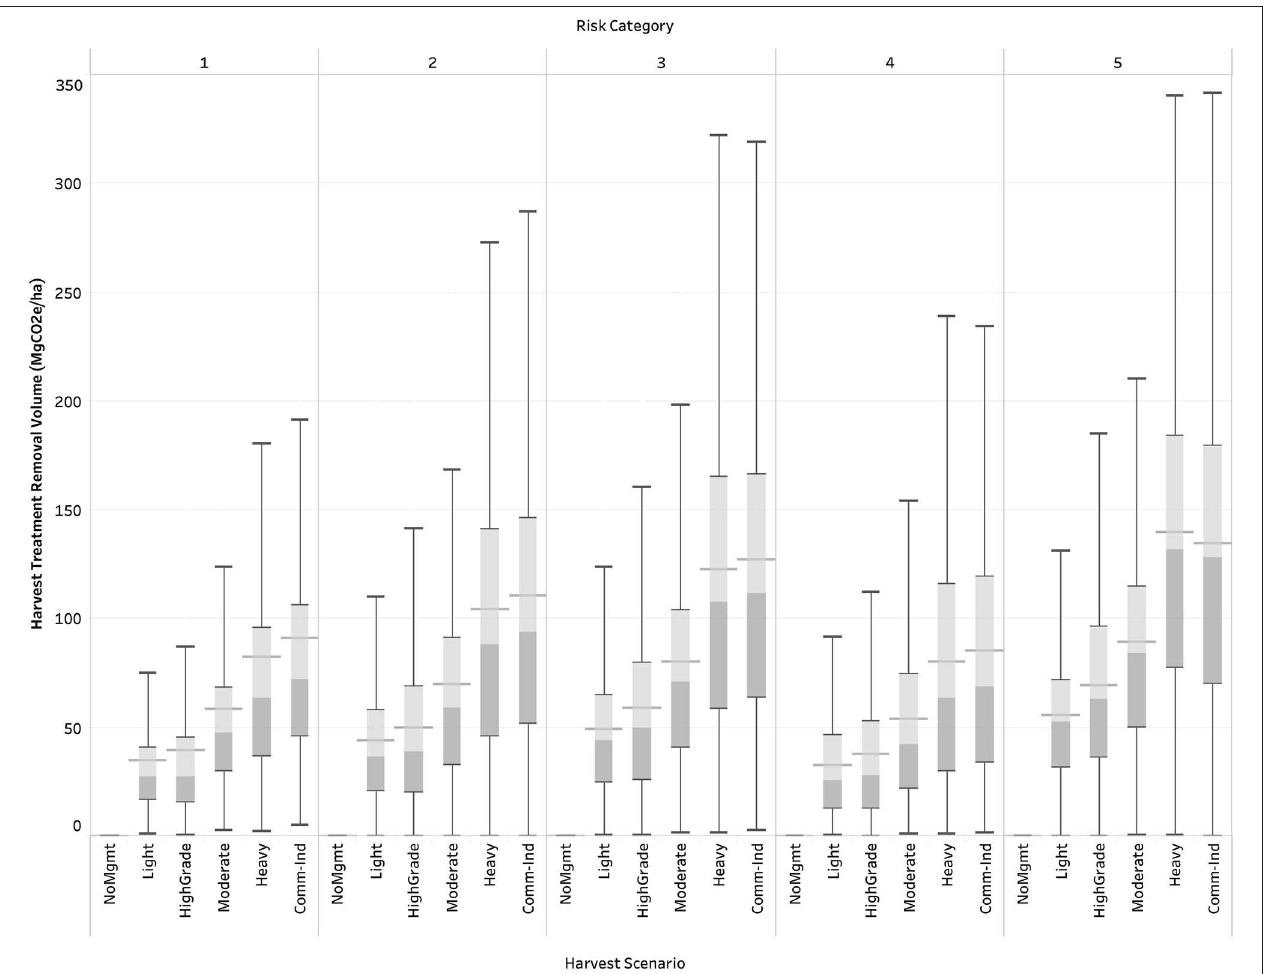
FIGURE 4 | Modeled harvest removal volume (in MgCO2e/ha) for all management scenarios (excluding salvage volume). Mean is indicated by horizontal bar. Light gray color indicates upper hinge (75th percentile, Tukey’s inclusionary hinge), dark gray indicates 25th lower hinge (25th percentile, Tukey’s inclusionary hinge). Whiskers denote all data points within 1.5 times the interquartile range.